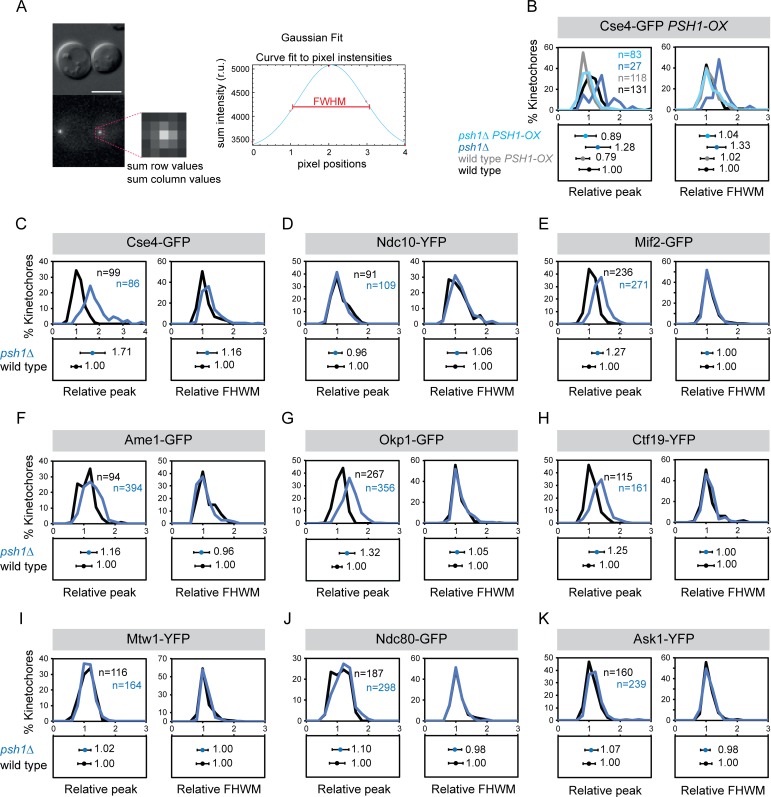
Changes in the size of kinetochore foci in psh1Δ mutant.(A) Strategy to fit Gaussian distribution to kinetochore foci. (B-K) Quantitation of size of kinetochore foci in wild type (black) and psh1Δ (blue) cells. The images used for Fig 2 quantitation were re-analysed to calculate peak height and FHWM shown in panels C-K. Fluorescence peak height values and full width at half maximum (FHWM) values are normalised relative to wild-type mean intensity ± standard deviation. Top panels and bottom panels display the distribution of intensities and the mean intensity ± standard deviation, respectively. (B) Cse4-GFP PSH1-OX. Peak height: wild type 1.00±0.32, wild type PSH1-OX 0.79±0.22, psh1Δ 1.28±0.41, psh1Δ PSH1-OX 0.89±0.34. FWHM: wild type 1.00±0.23, wild type PSH1-OX 1.02±0.22, psh1Δ 1.33±0.30, psh1Δ PSH1-OX 1.04±0.26. (C) Cse4-GFP. Peak height: wild type 1.00±0.22, psh1Δ 1.71±0.53***. FHWM: wild type 1.00±0.23, psh1Δ 1.16±0.32***. (D) Ndc10-YFP. Peak height: wild type 1.00±0.24, psh1Δ 0.96±0.21. FHWM: wild type 1.00±0.29, psh1Δ 1.06±0.31. (E) Mif2-GFP. Peak height: wild type 1.00±0.17, psh1Δ 1.27±0.26***. FHWM: wild type 1.00±0.21, psh1Δ 1.00±0.18. (F) Ame1-GFP. Peak height: wild type 1.00±0.25, psh1Δ 1.16±0.26***. FHWM: wild type 1.00±0.25, psh1Δ 0.96±0.26. (G) Okp1-GFP. Peak height: wild type 1.00±0.16, psh1Δ 1.32±0.25***. FHWM: wild type 1.00±0.21, psh1Δ 1.05±0.24. (H) Ctf19-YFP. Peak height: wild type 1.00±0.17, psh1Δ 1.25±0.25***. FHWM: wild type 1.00±0.26, psh1Δ 0.96±0.2. (I) Mtw1-YFP. Peak height: wild type 1.00±0.21, psh1Δ 1.02±0.19. FHWM: wild type 1.00±0.20, psh1Δ 1.00±0.18. (J) Ndc80-GFP. Peak height: wild type 1.00±0.25, psh1Δ 1.10±0.27. FHWM: wild type 1.00±0.23, psh1Δ 0.98±0.21. (K) Ask1-YFP. Peak height: wild type 1.00±0.2, psh1Δ 1.07±0.22. FHWM: wild type 1.00±0.19, psh1Δ 0.98±0.15.